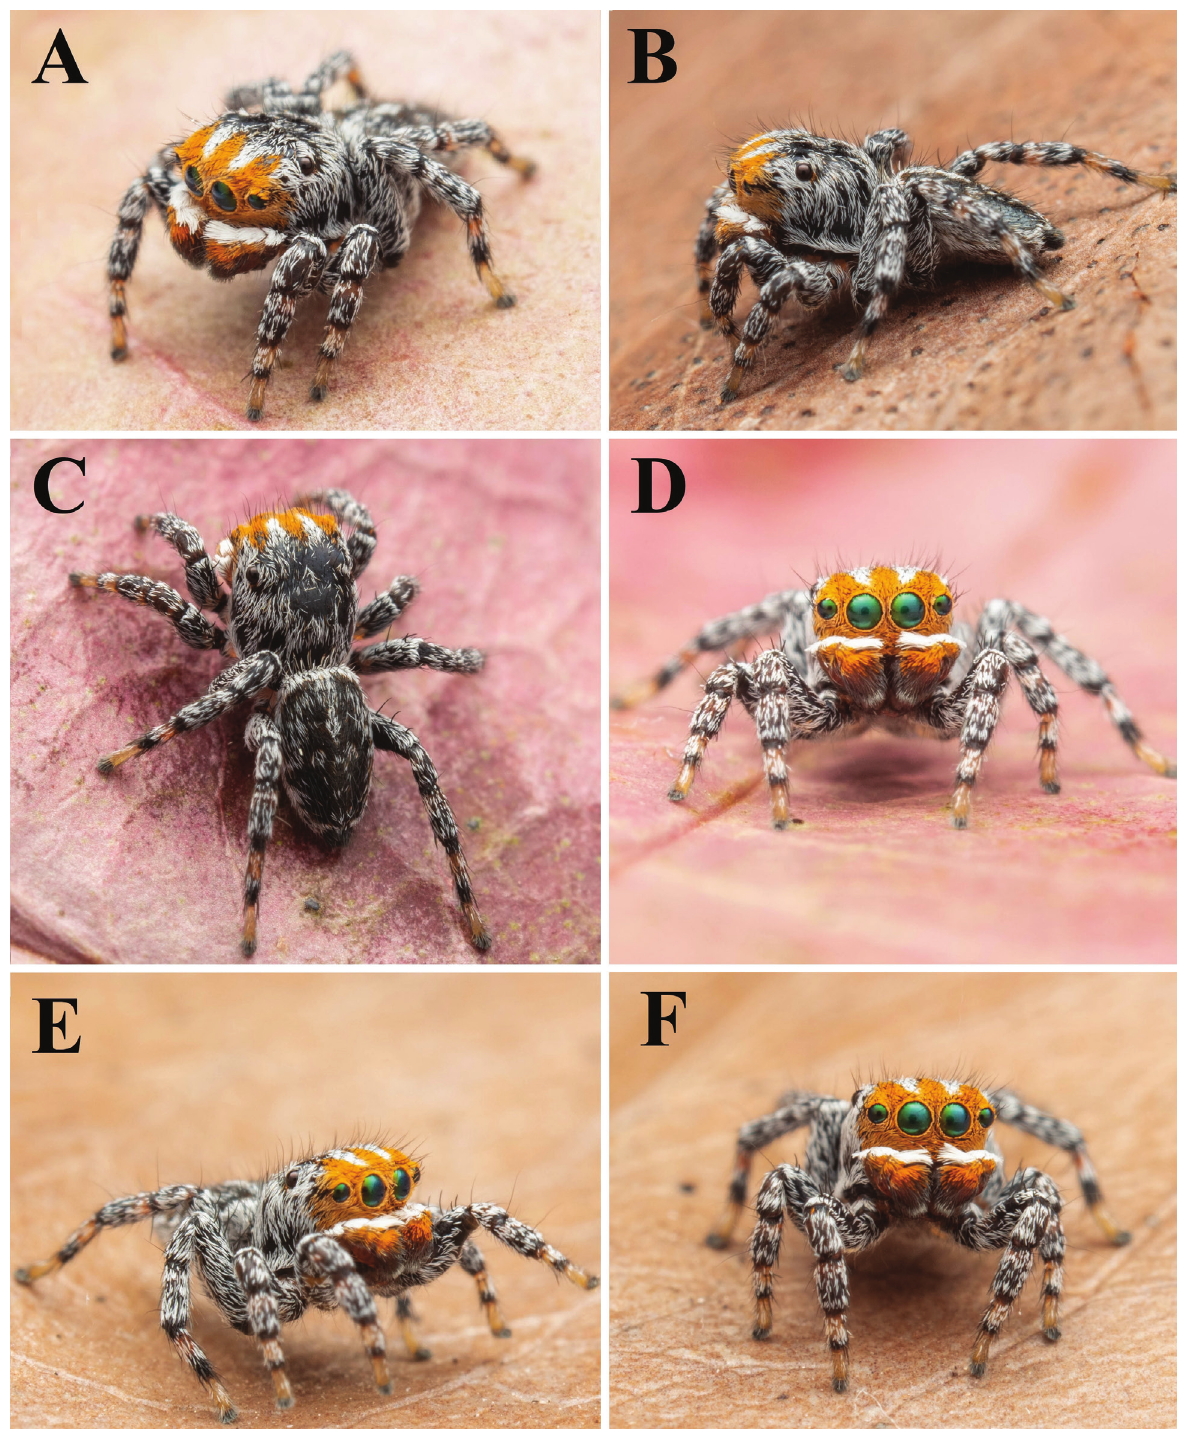
Figure 1. Habitus of living paratype male Maratus nemo sp. nov. (SAM NN30709) A anterolateral view B lateral view C dorsal view D anterior view E anterolateral view F anterior